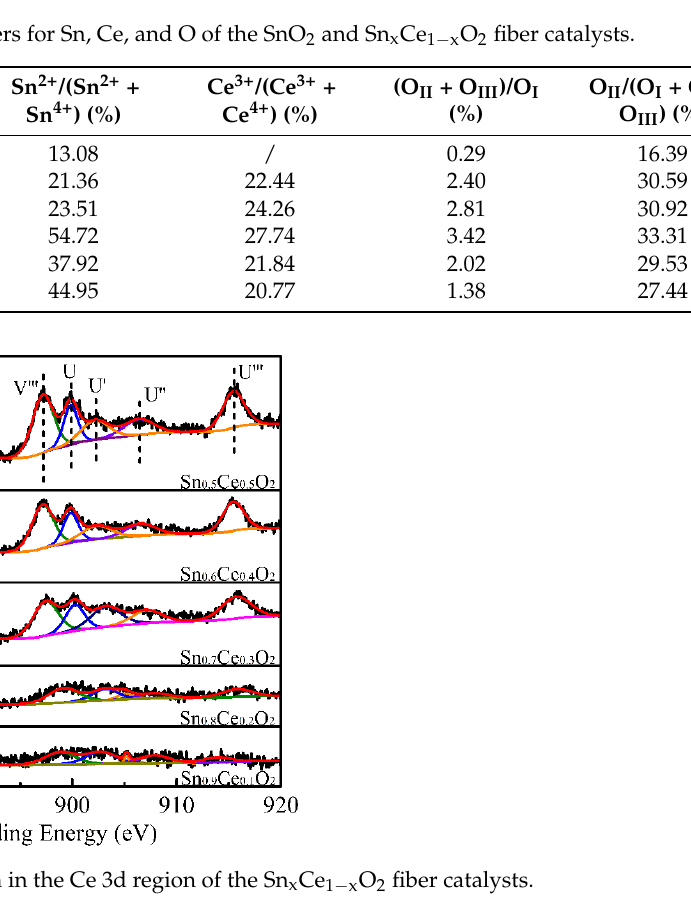
x Ce 1 − x O 2 fiber